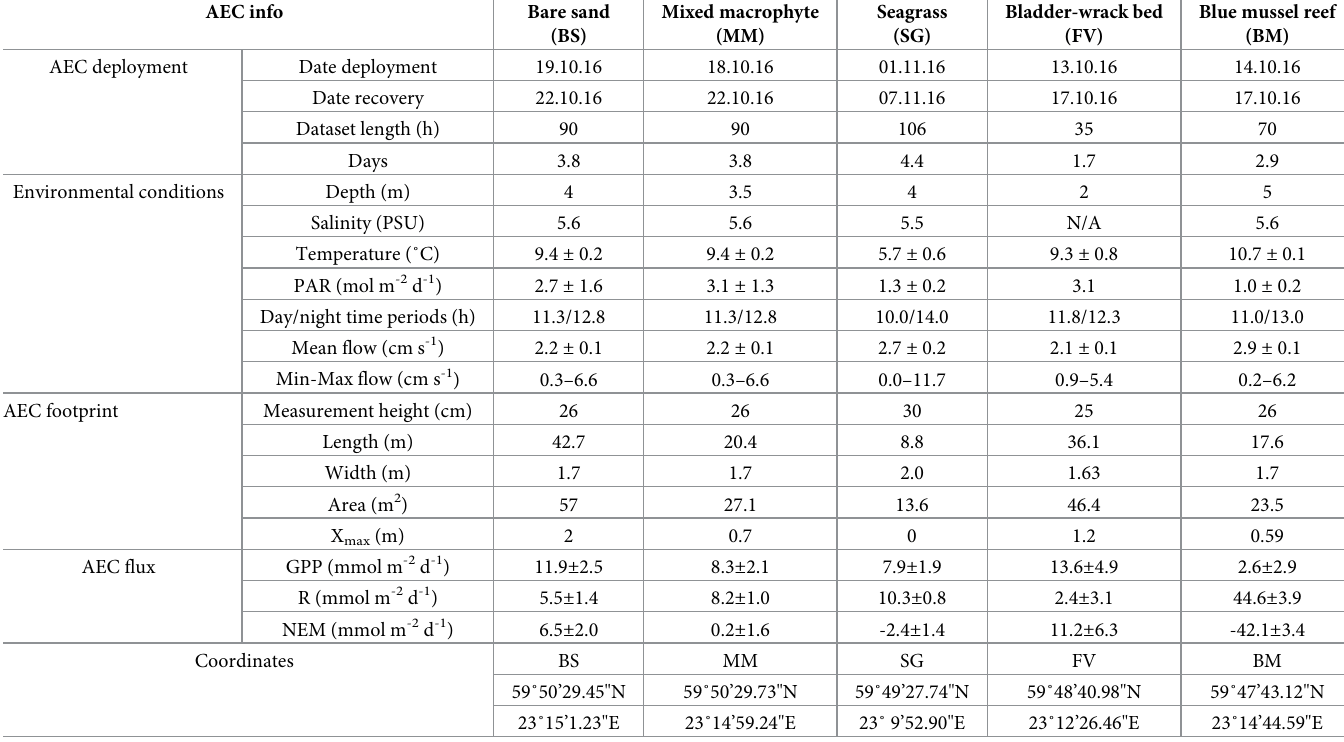
Table 1. Aquatic eddy covariance (AEC) deployment information and environmental characteristics (mean ± SE). This table includes information on the AEC foot- print area and productivity flux estimates (Gross primary production, GPP, community respiration, R, and net ecosystem metabolism, NEM) at the five habitats. Photosyn- thetic active radiation (PAR) is calculated as an integration of continuous measurements over 24 h. X max is the integrated area with the maximum flux contribution (see